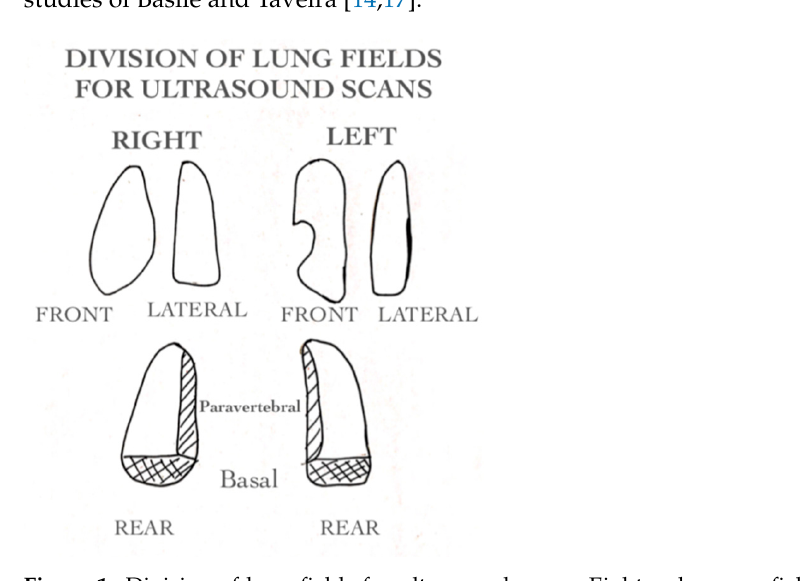
Figure 1. Division of lung fields for ultrasound scans. Eight pulmonary fields were explored in each ultrasound. For each field longitudinal and transverse scans were made for a total of sixteen ultrasound scans.